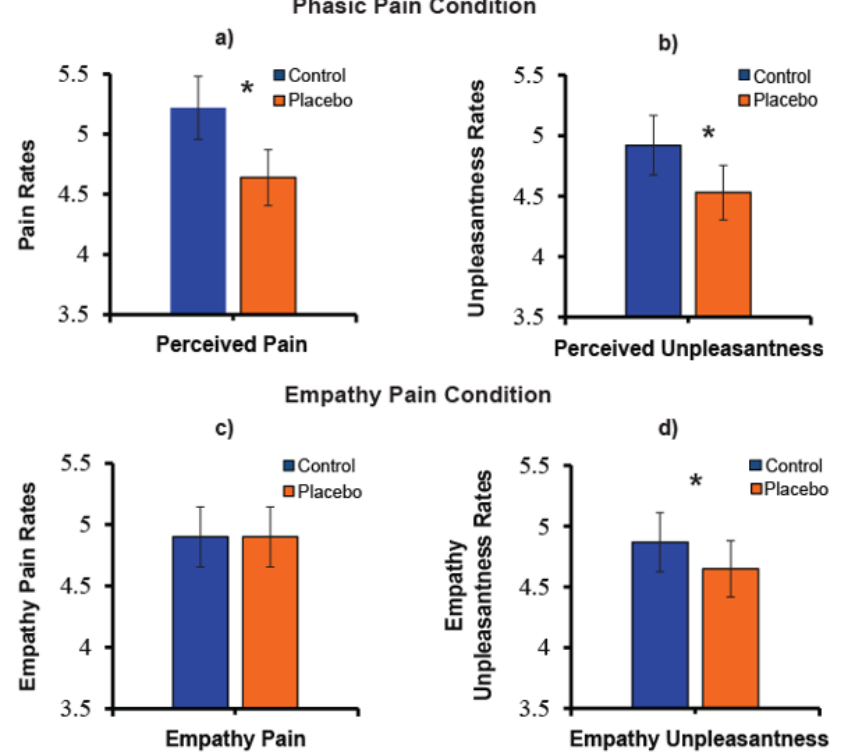
Figure 4. ( a ) Pain rating mean values of perceived pain in control and placebo treatment ( N = 63); ( b ) Unpleasantness values of perceived unpleasantness mean values in control and placebo treatment ( N = 63); ( c ) Empathy for pain mean ratings in control and placebo treatment ( N = 63); ( d ) Empathy for unpleasantness mean ratings in control and placebo treatment.“*” Significant planned comparisons, p < 0.05.